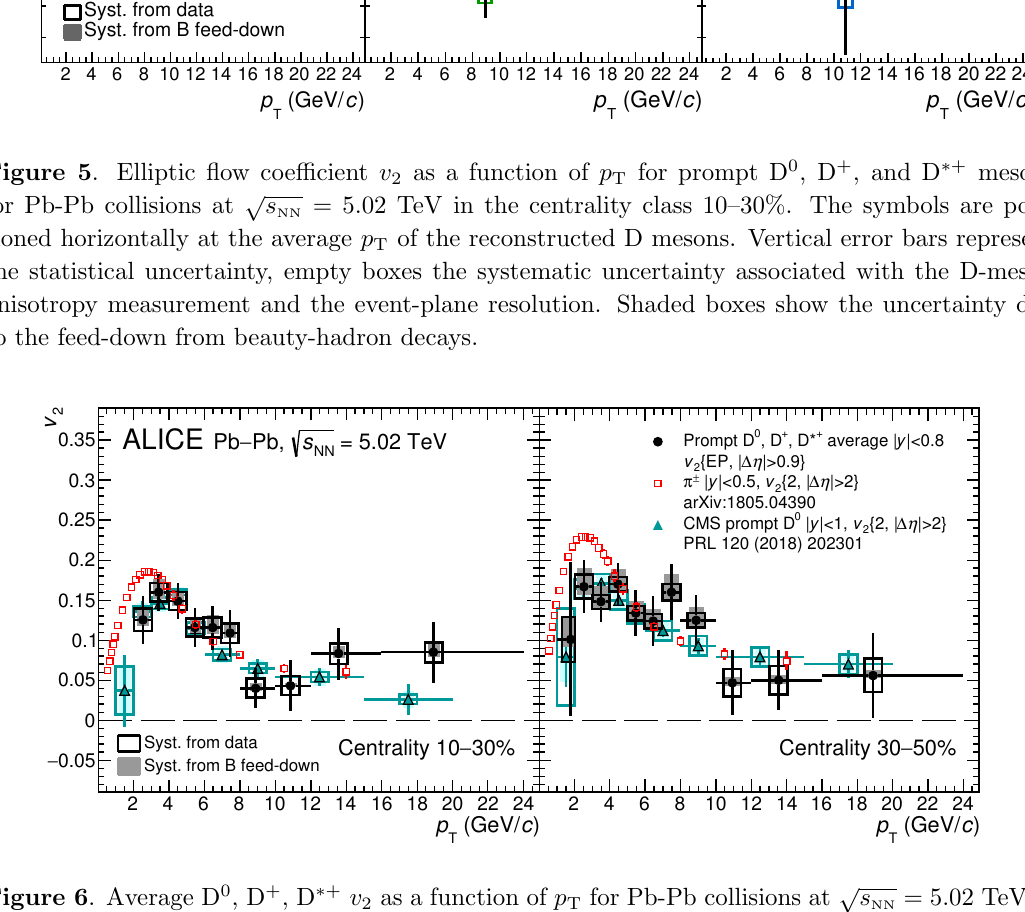
Figure 6 . Average D 0 , D + , D (cid:3) + v 2 as a function of p T for Pb-Pb collisions at the centrality classes 10{30% (left) and 30{50% [48] (right). The comparison with the measurement of the D 0 v 2 by the CMS Collaboration [49] and the charged pion v 2 [91] in the same centrality intervals is also